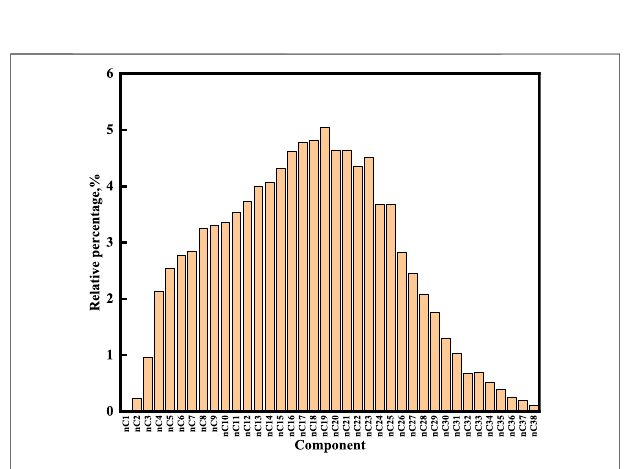
FIGURE 2 | Fluid component analysis results.